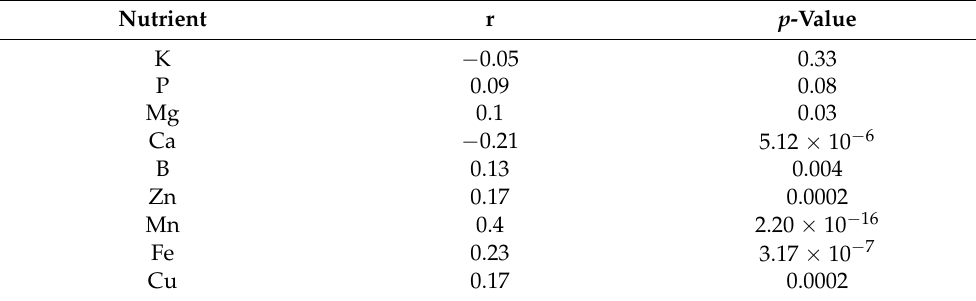
Table 2. Corresponding p -values and r values (Pearson’s coefficient) of correlations examined between soil nutrient concentrations and ground-applied CRF treatments from all time points of